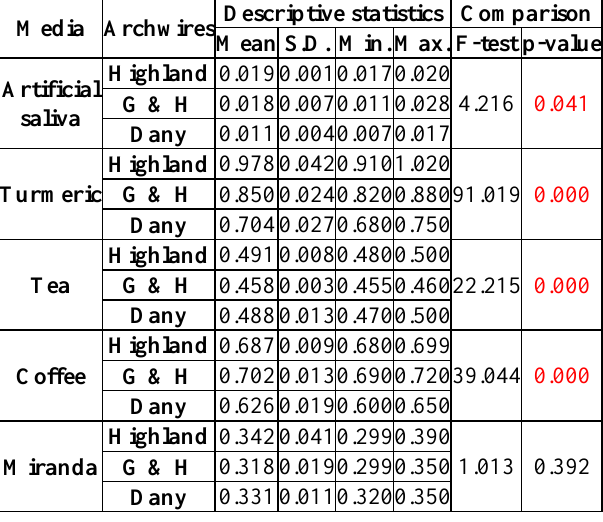
Table 3: Descriptive statistics and comparison of the degree of color absorption after 21 days of immersion.